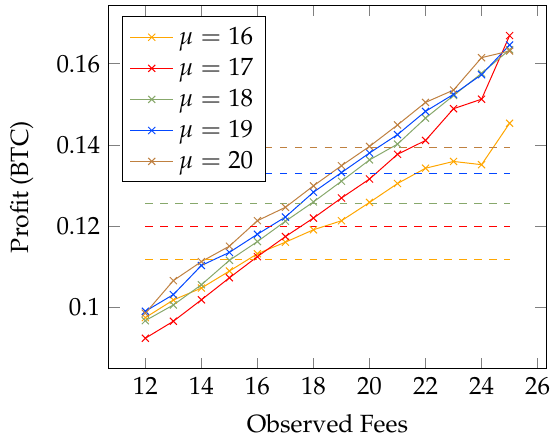
Figure 1. The graph relates the average Bitcoin fee rate and the miner profit. Data are computed by setting the parameters for the Gaussian distribution for block size as µ = 700 and σ 2 = 25 and for rewards as σ 2 = 5 and µ according to the legend. The dashed lines represent the values computed with mc_expectation/3 (without observations).